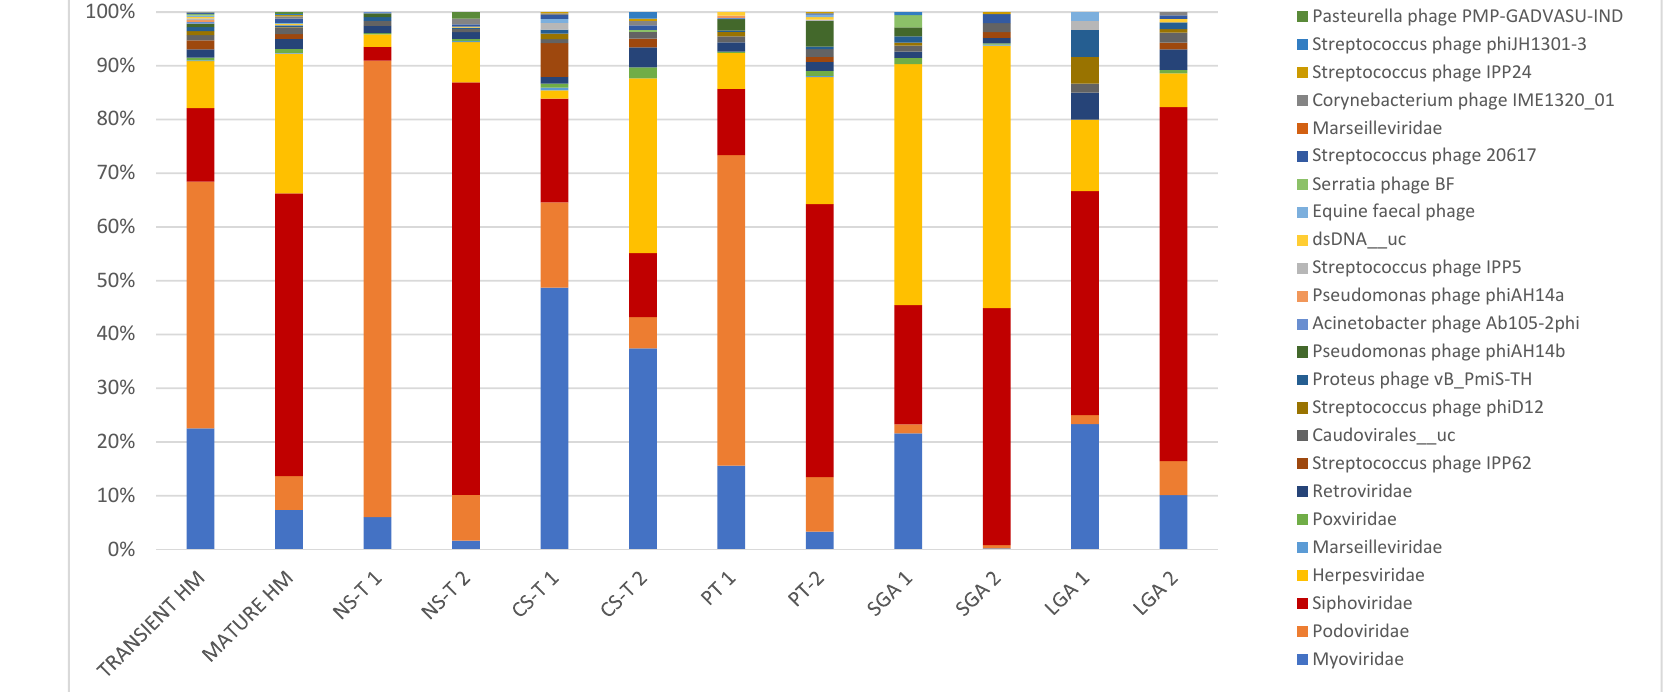
Figure 1. In transient and mature human milk samples, the most abundant taxa in terms of mode of delivery form, prematurity, and birth weight for gestational age. Bacteriophages were predominant in transient human milk samples: in the vaginal delivery group at 98.4%, at 92.1% in the premature group, at 89.9% in the C-section group, and at 68.3% in the LGA group, except in the SGA group (only ~45% bacteriophages in TMS). Bacteriophages were also predominant in mature human milk samples; however, they were lower in mature human milk samples than in transient human milk samples (71.7% in the vaginal delivery group, 60.8% in the C-section-term group, 56% in the premature group, and 80.6% in the LGA group). Bacteriophages accounted for 45% of mature human milk samples in the SGA group. NS-T: normal spontaneous vaginal delivery-term; CS-T: cesarean delivery-term; PT: premature; SGA: small for gestational age; LGA: large for gestational age for all groups; 1: transient milk; 2: mature milk.